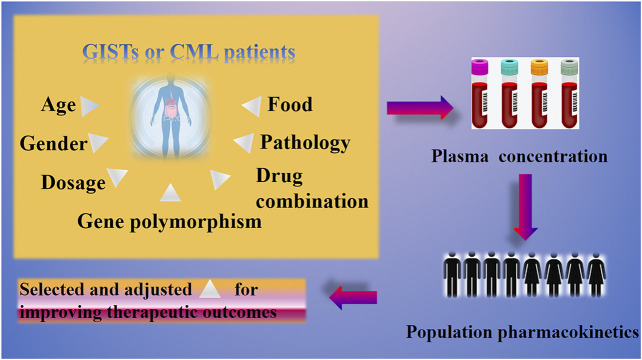
Graphical abstract.